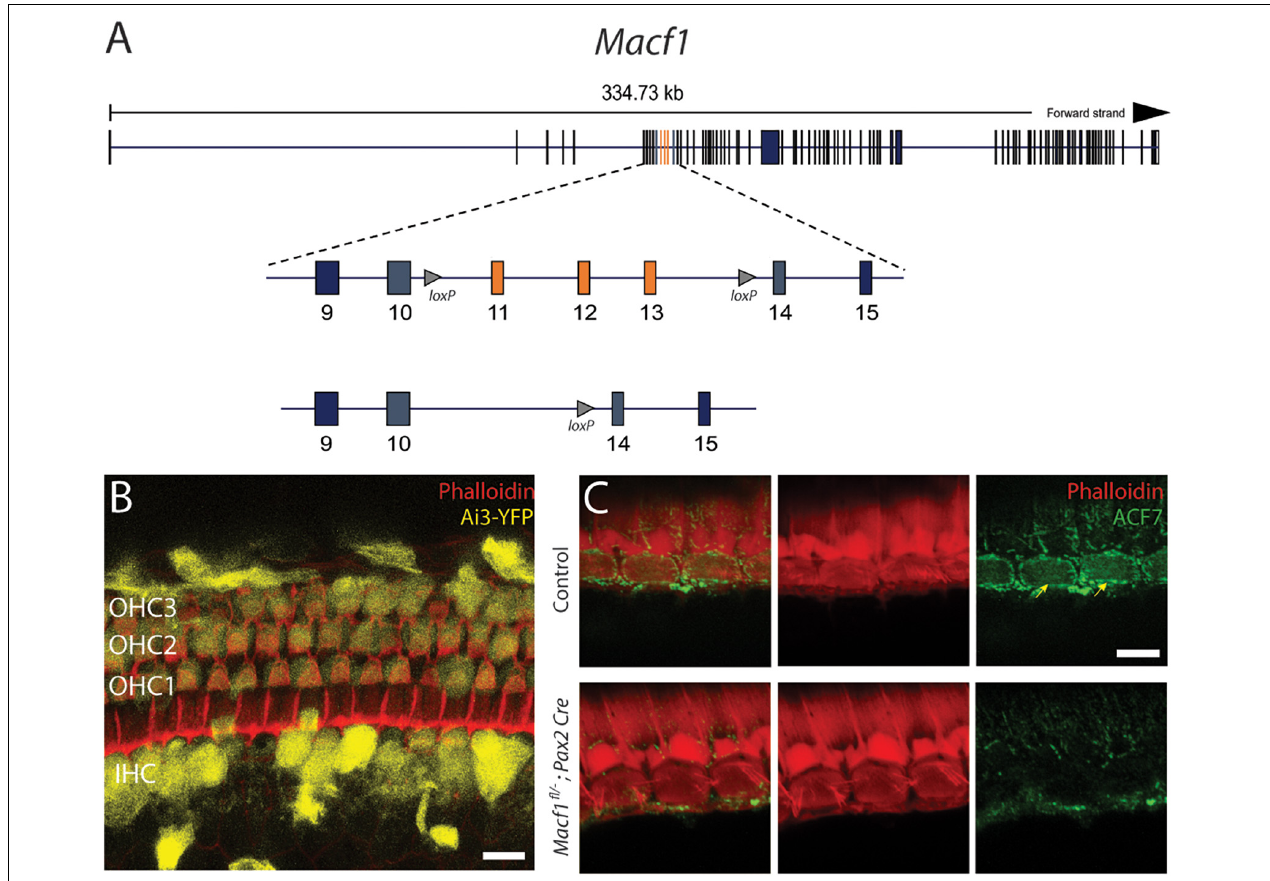
FIGURE 1 | Conditional gene ablation of Macf1 in mouse inner ear hair cells. (A) (top) Schematic of the Macf1 genomic locus. (middle) Enlarged view of exons 9–15 are displayed. Exons 11–13 (orange) are flanked by loxP sites (triangles). (B) Representative confocal micrograph of a segment of the apical turn ( ∼ 8 kHz) of a cochlea from a Cre reporter Ai3-YFP mouse at one month of age that expresses Cre driven by the Pax2 promoter, generated to determine the efficacy of Cre-mediated recombination in hair cells. Cells that express YFP (yellow) indicate successful Cre-mediated recombination. Hair cells of the cochlea express YFP. Phalloidin (red) labels actin of cells. Scale bar = 10 µ m. (C) Representative confocal micrographs of IHCs from the middle turns ( ∼ 16 kHz) of cochleae of one-month old mice labeled with anti-ACF7 antibody [ (top) sibling control; (bottom) Macf1 fl / − ; Pax2 - Cre )]. Anti-ACF7 and phalloidin depicted in green and red, respectively. Arrows show cuticular plates with ACF7 antibody labeling. Hair bundles that appear missing are present but out of focus. Scale bar = 5 µ m.